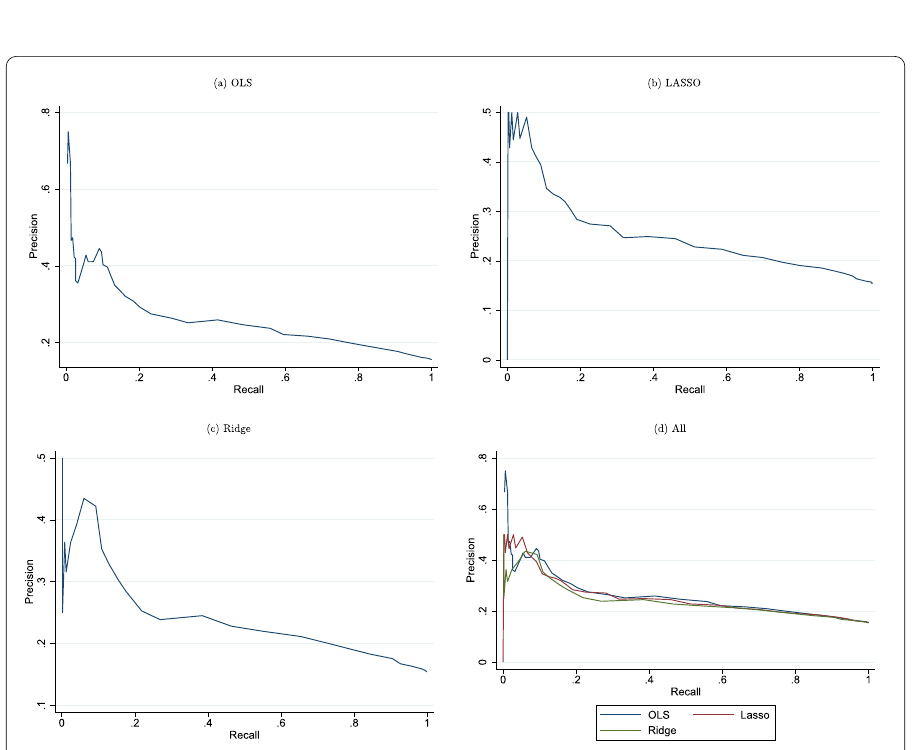
Figure A.2 Precision and recall curves. Small model—verification